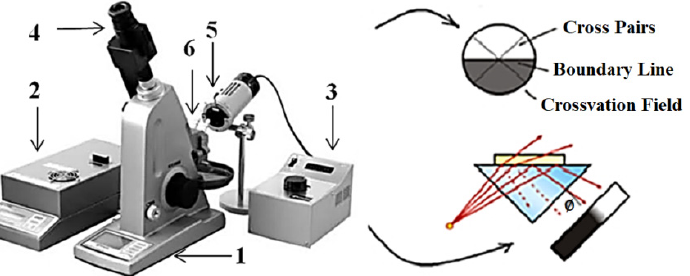
Figure 3. Schematics of the Abbe refractometer (Atago, Japan), which consists of the following: (1) electronic refractometer, (2) power supply, (3) multi-wavelength light source, (4) the eyepiece imager for measurements in the NIR region, (5) interference filter, and (6) sample place.